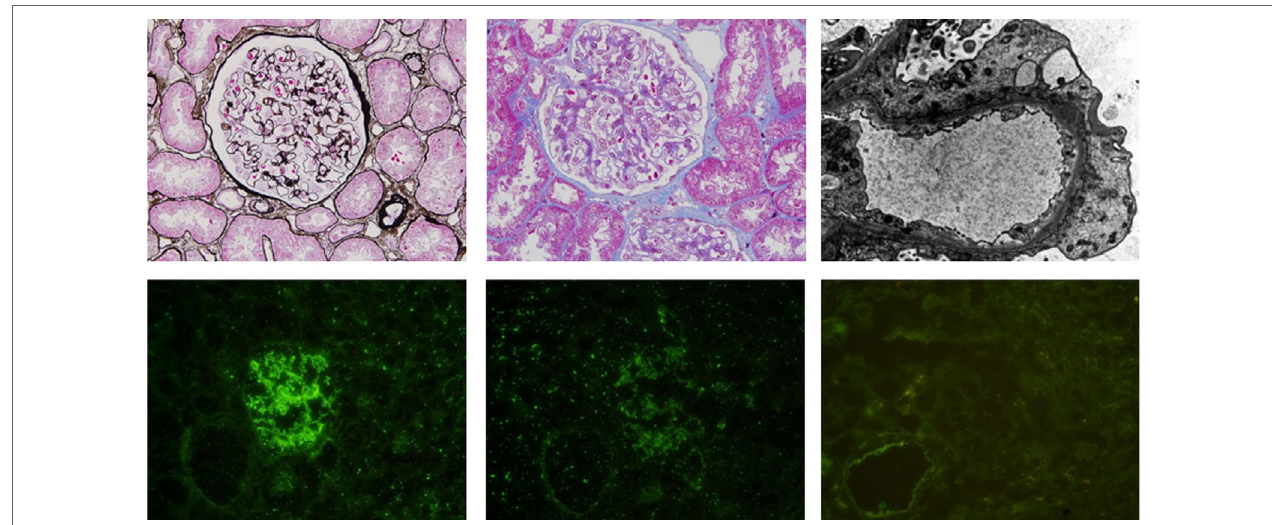
FIgURe 1 | (a) (Above, left). Glomerular basement membrane irregular thickening and segmental spikelike projections were observed by periodic acid-silver methenamine staining. (B) (Above, middle). Granular fuchsinophilic protein was found to be subepithelial using Masson’s trichrome staining. (C) (Above, right). Electron micrograph demonstrating a few electron-dense deposits in the subepithelial basement membrane and fusions of most foot processes. Depositions of IgG (D) (below, left) and C3 (e) (below, middle) are shown by immunofluorescence microscopy. (F) (Below, right). PLA2R1 is